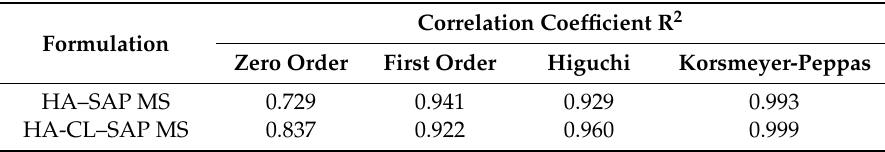
Table 4. Correlation coefficient for Zero order, First order, Higuchi, and Korsmeyer – Peppas models for SAP dissolution profiles obtained with Franz diffusion cell